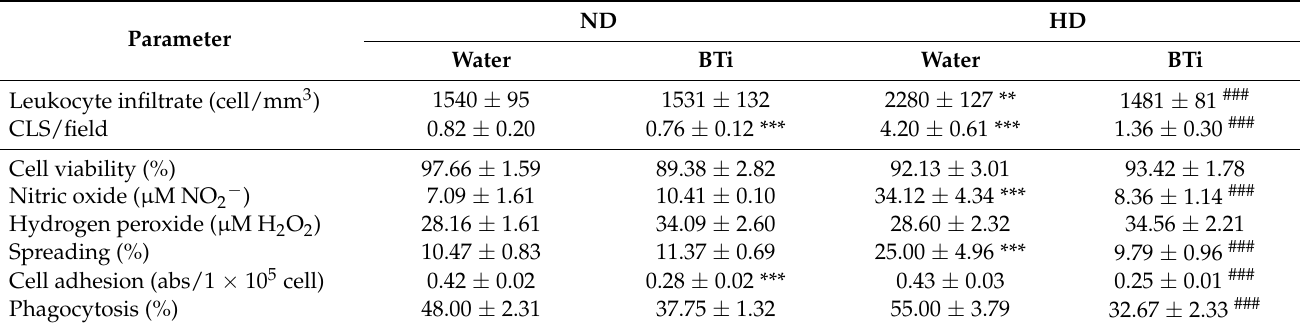
Table 4. Effect of BTi on leukocyte infiltrate, formation of crown-like structures (CLS) by macrophages, around adipocytes, and cellular functions of